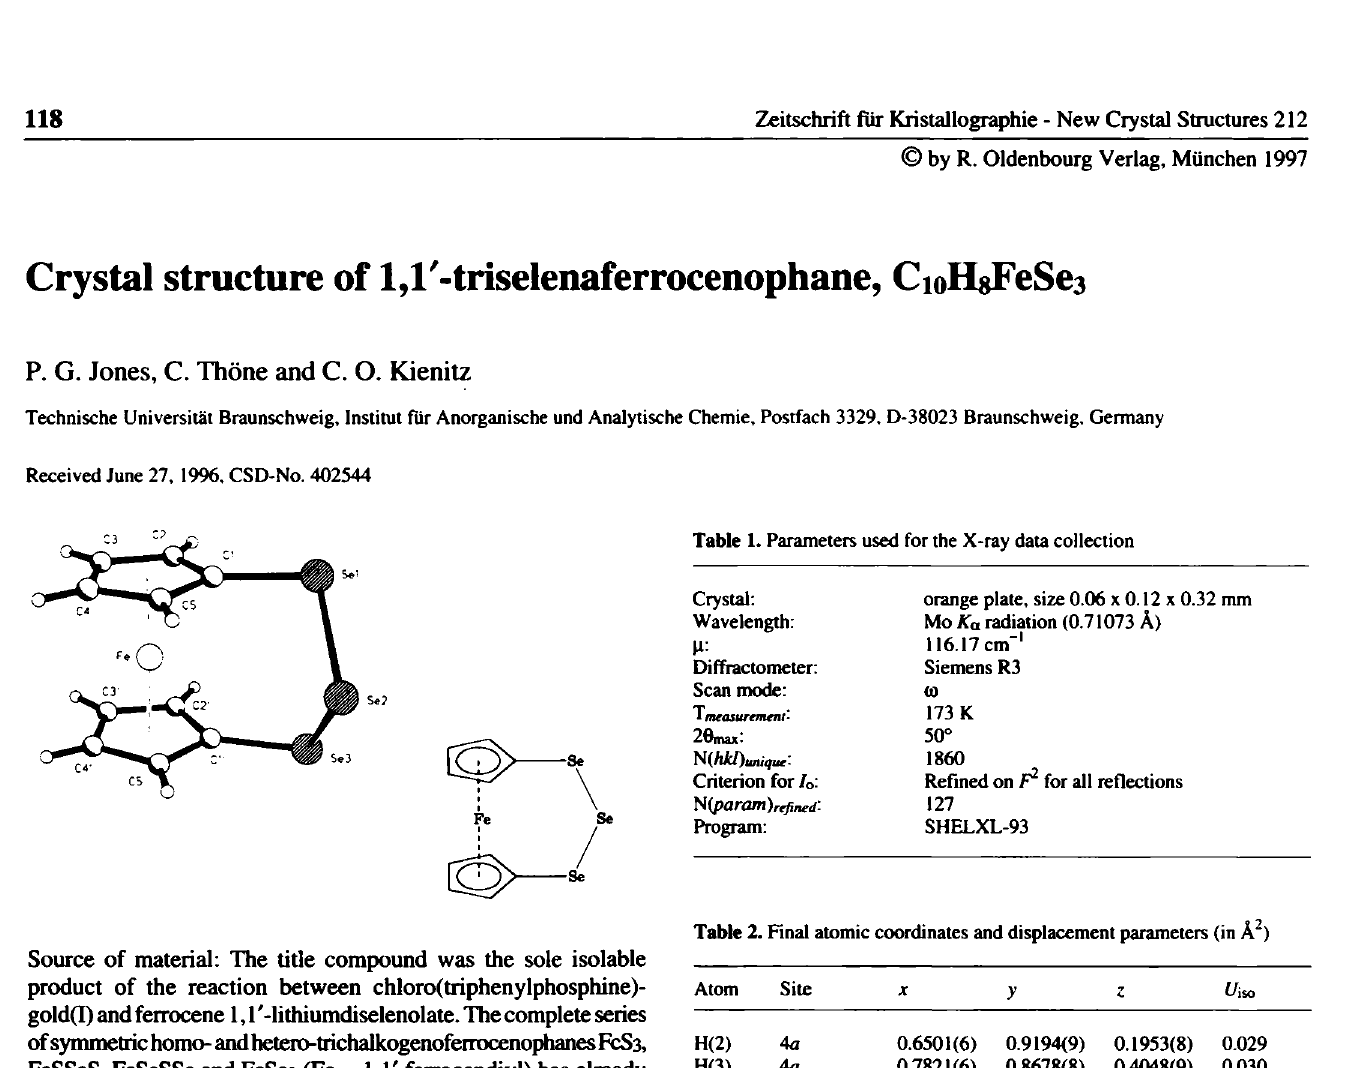
Table 2. Final atomic coordinates and displacement parameters (in Â 2